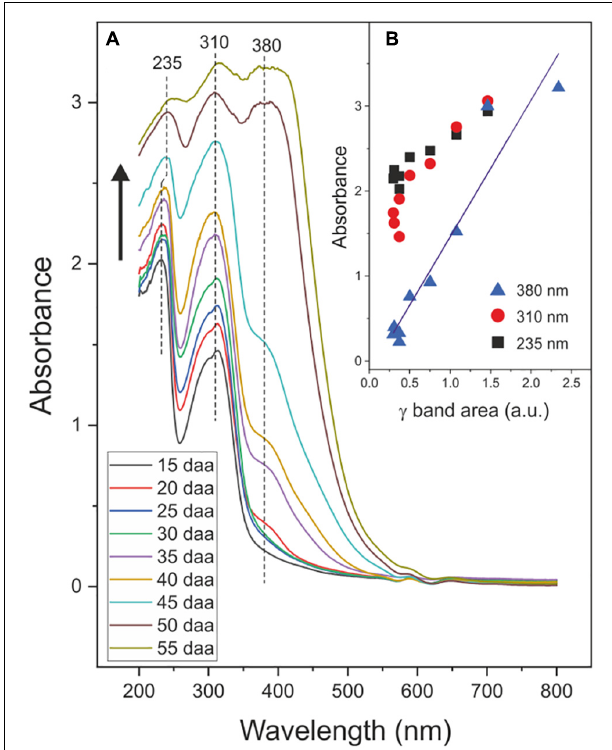
FIGURE 8 | (A) Absorbance spectra of isolated tomato CMs during fruit growth and ripening. Black arrow indicates the evolution of spectra with the developmental stage. (B) Relationship between the absorbance at 235, 310, and 380 nm and the phenolic content via the quantification of the ATR-FTIR γ